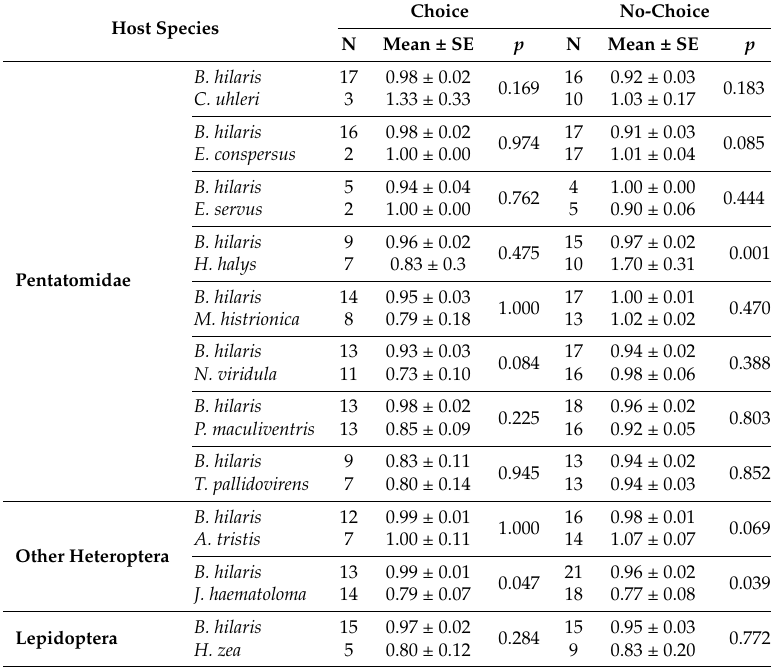
Table 4. Ooencyrtus mirus immature survival: mean ( ± SE) proportion of emerged progeny from host eggs with one or more O. mirus egg